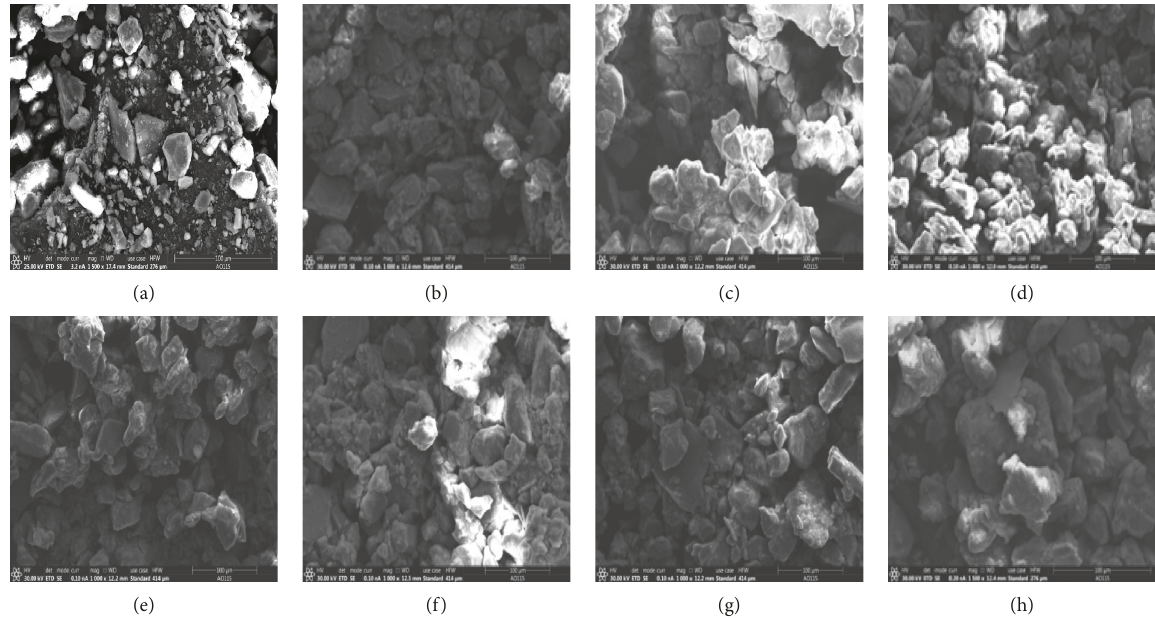
Figure 7: 7 SEM images of loess samples modified by different proportions of the microbial cementation solution. (a) The original